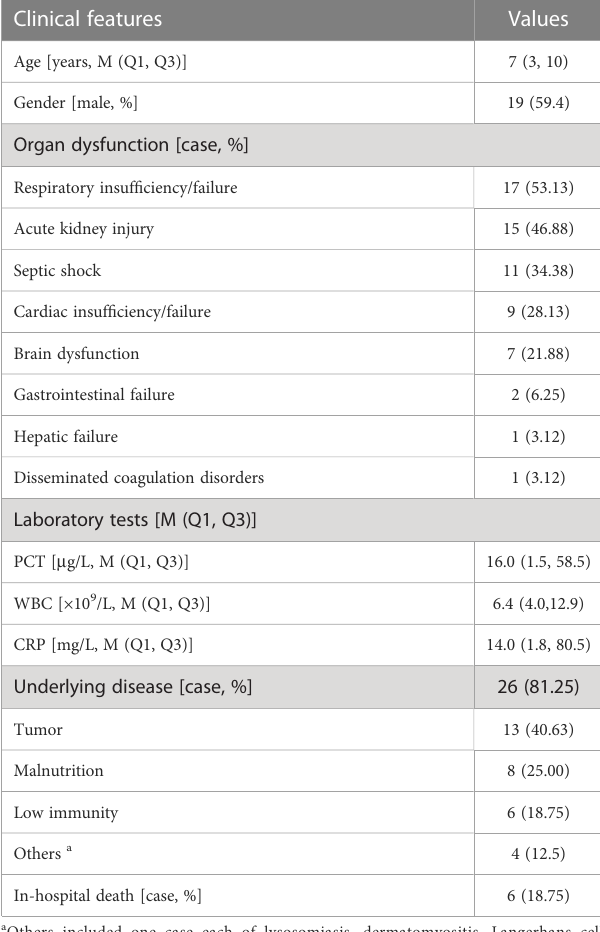
TABLE 1 Clinical features and laboratory tests of involved patients (N=32).